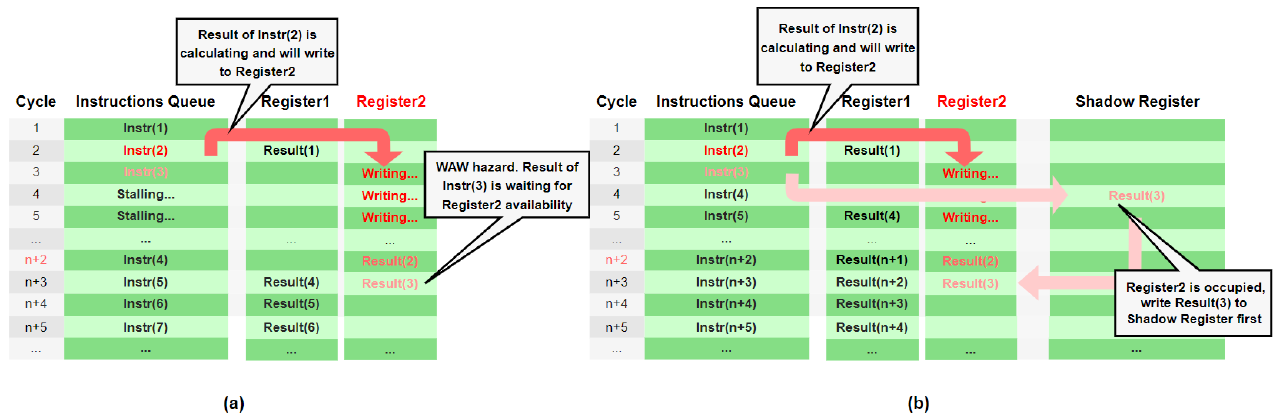
Figure 9. Theoretical analysis of the shadow register. ( a ) Without shadow register. ( b ) Optimized with shadow register.